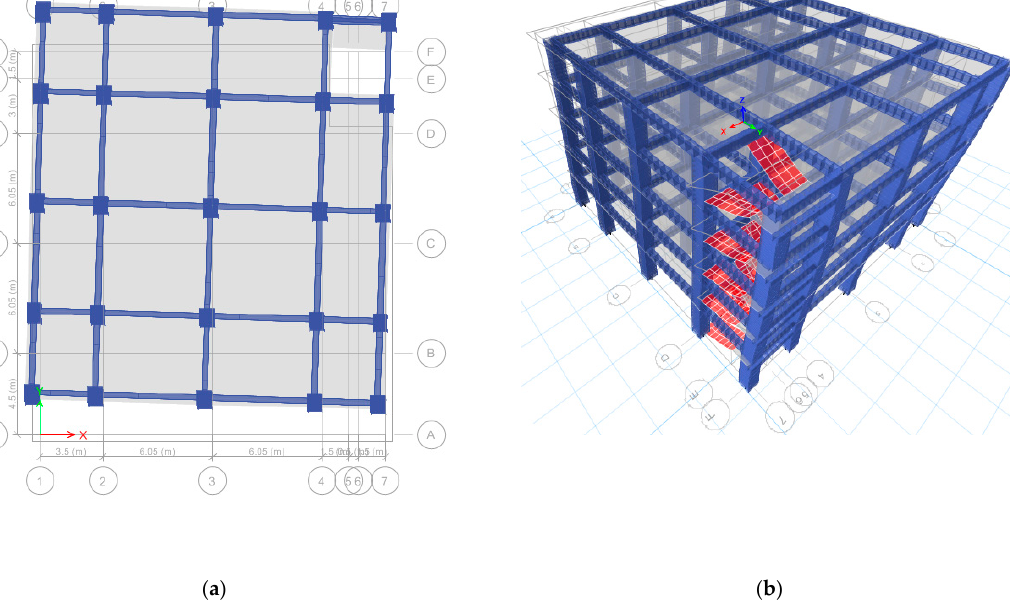
( b ) Figure 14. The 1st mode shape for T 2 = 0.376 s: ( a ) plane view, and ( b ) 3D view.